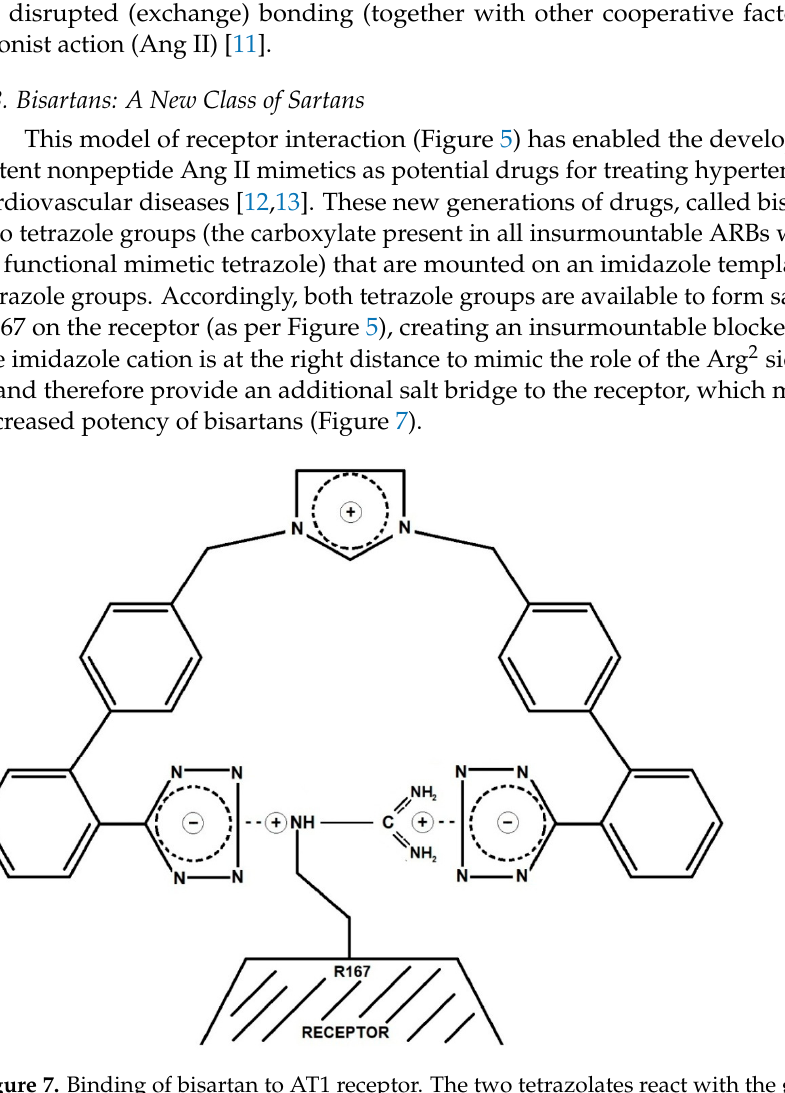
Figure 7. Binding of bisartan to AT1 receptor. The two tetrazolates react with the guanidino group of Arg167.